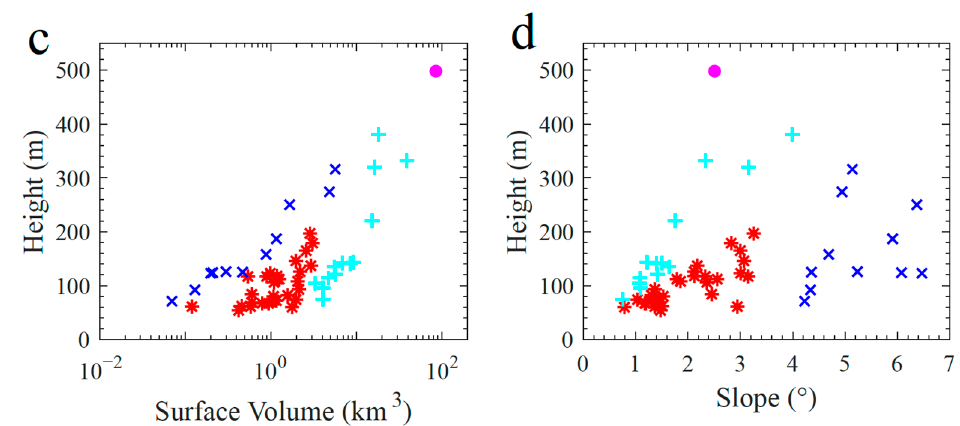
Figure A1. Graphs showing the variation of ( a ) height vs. diameter, ( b ) height vs. area, ( c ) height vs. surface volume, and ( d ) height vs. average flank Sof 54 domes in both the Gardner volcano and mare Tranquillitatis.